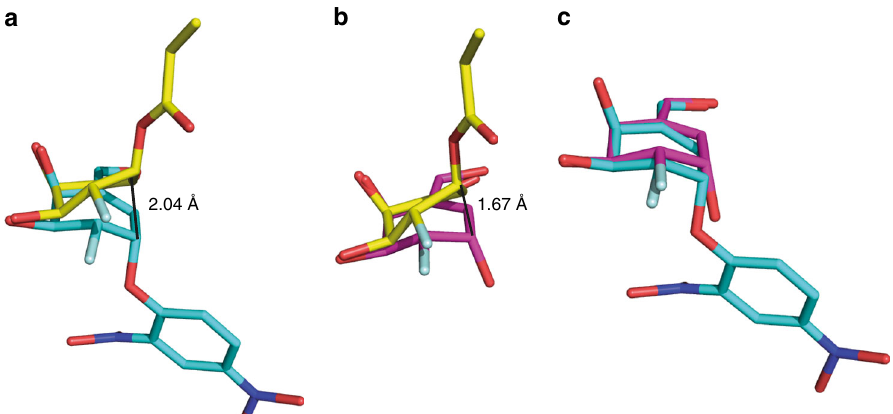
Fig. 9 Superposition of Tm GalA structures. a Structure of Tm GalA mutant D387A in complex with intact 4 (cyan) and of wild-type Tm GalA in complex with 2-deoxy-2- fl uorocarbagalactose fragment of 4 covalently bound to the nucleophile Asp327 (yellow). b Structure of wild-type Tm GalA in complex with hydrolyzed inhibitor 6 (pink) and of wild-type Tm GalA in complex with 2-deoxy-2- fl uorocarbagalactose fragment of 4 covalently bound to the nucleophile Asp327 (yellow). c Structure of Tm GalA mutant D387A in complex with intact 4 (cyan) and of wild-type Tm GalA in complex with hydrolyzed